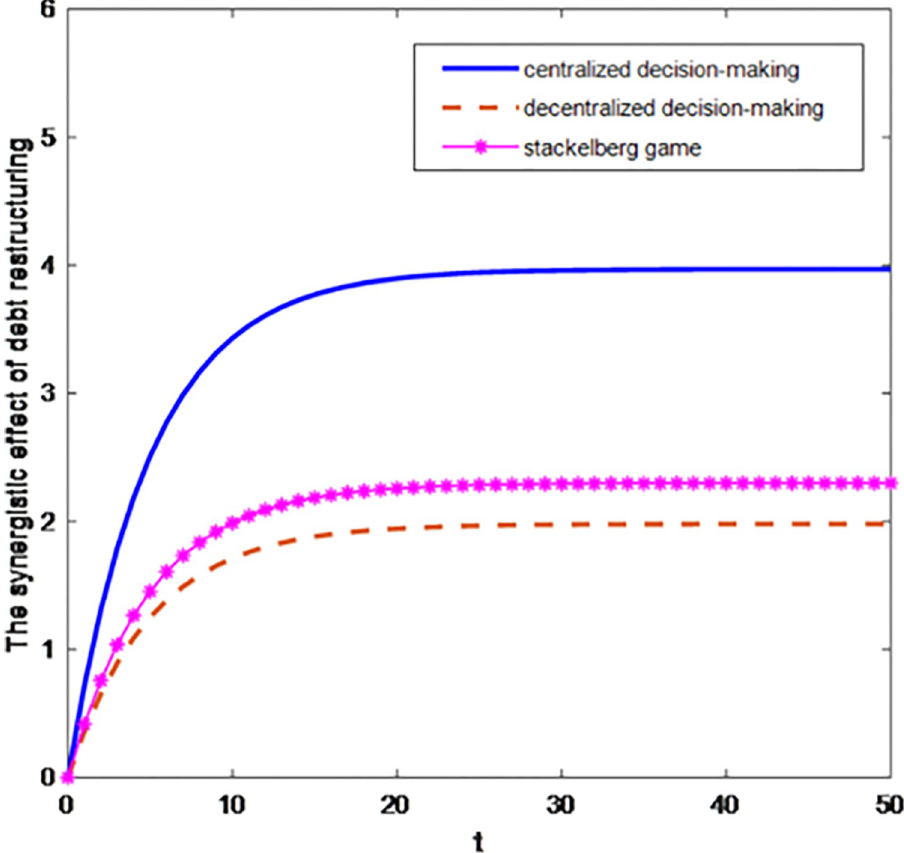
Fig 1. The synergistic effect of debt restructuring under three game